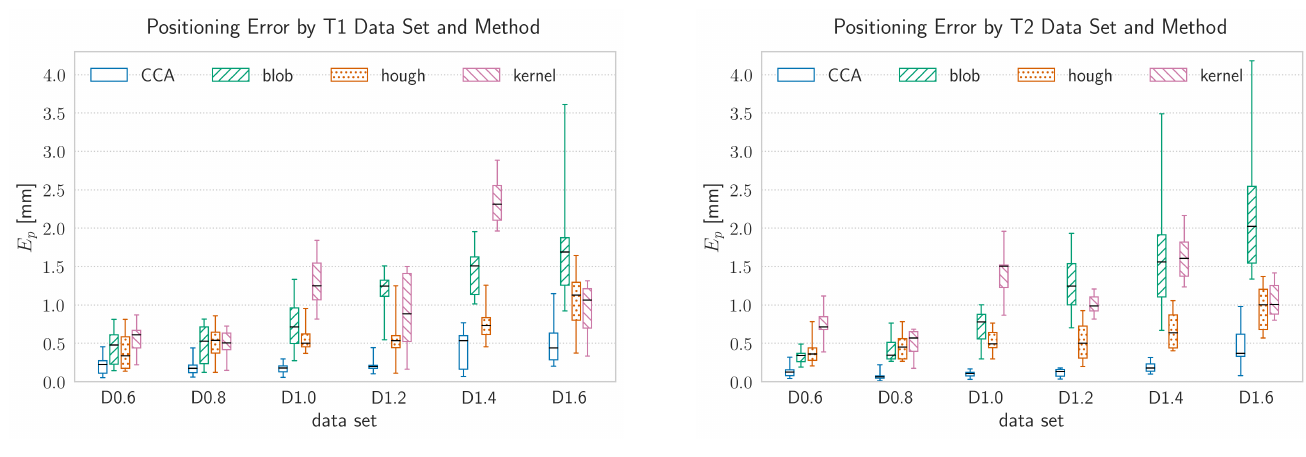
Figure 8. The positioning error, E p , by data-set and method. E p was evaluated using the Euclidean distance between the positions of the detected markers to the ground-truth measurement. Each data-set was acquired at a different voxel size, ranging between s =[ 0.6, . . . ,1.6 ] mm in ∆ s = 2mm steps. The data-sets are ordered by increasing voxel size from left to right,